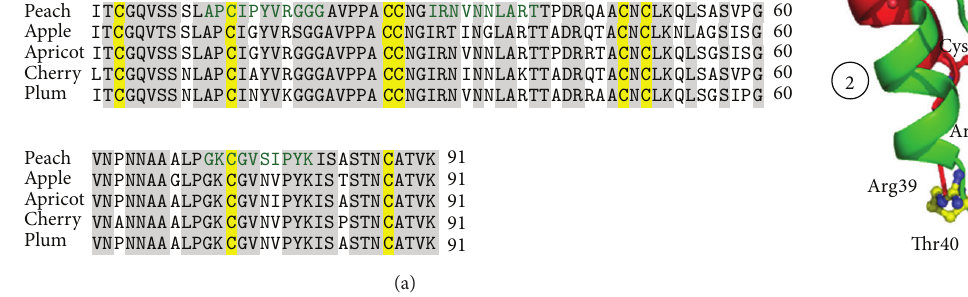
Figure 14: (a) Multiple sequence alignment of allergens of ns-LTPs from four Rosaceaefruits: peach, apple, apricot, and cherry. The identical sequences are highlighted in grey. Eight conserved cysteine residues are highlighted in yellow. The speculated three IgE binding epitopes of Pru p 3 from peach are marked in green. (b) Overall structure of ns-LTP, Pru p 3 showing the three possible IgE epitope binding regions (in green) marked from 1 to 3. The five charged residues in yellow having a possible role in epitope recognition and the eight cysteine residues forming four disulphide bridges are also